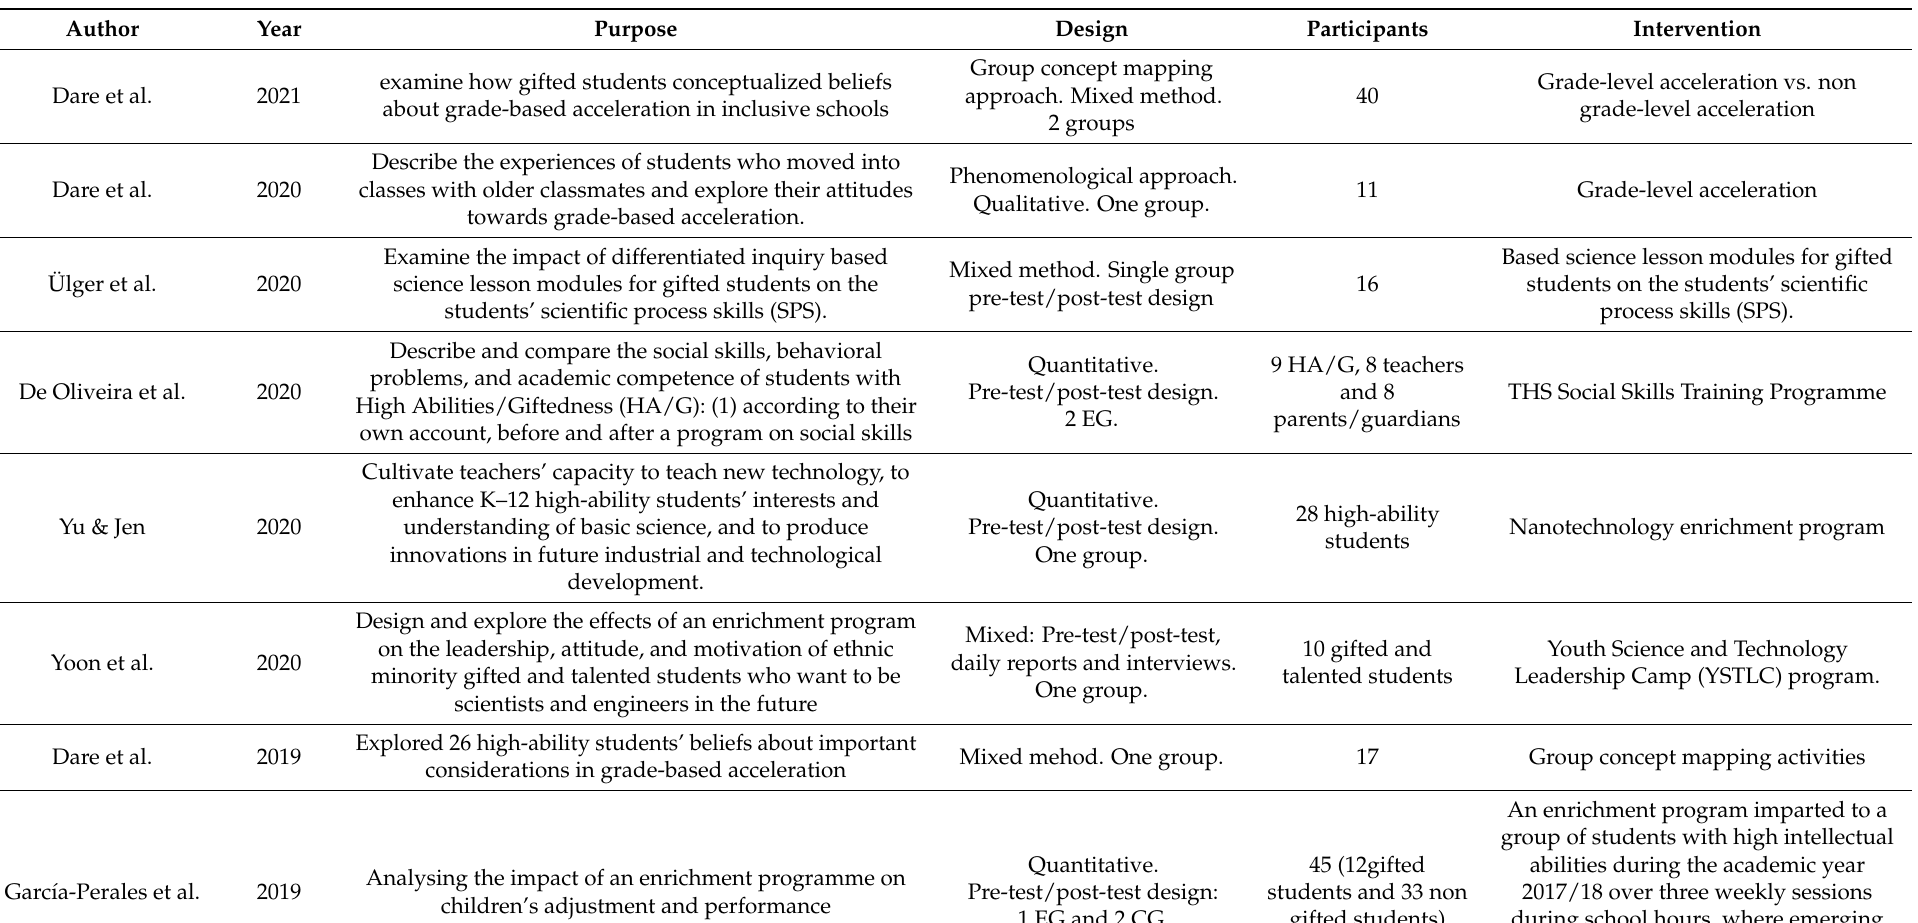
Table 1. Analysis of selected studies